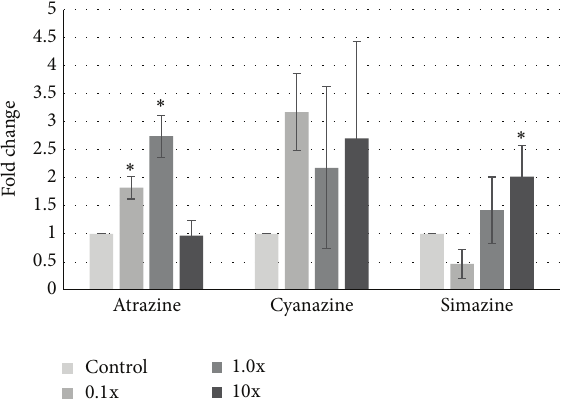
Figure 2: Increases in GPR30 expression in MCF-7 cells after atrazine exposure. MCF-7 human breast cancer cells were treated with 0.1- to 10-fold concentrations of the EPA safe levels of atrazine, cyanazine, or simazine for 24 hours. mRNA was harvested, cDNA was synthesized, and specific amplicons were prepared using primers to GAPDH (reference gene) or GPR30. Resulting fold changes in expression ± standard deviation are shown, with the vehicle control set at 1. Statistically significant changes in induction compared to the control are indicated ( ∗ 𝑝 < 0.05